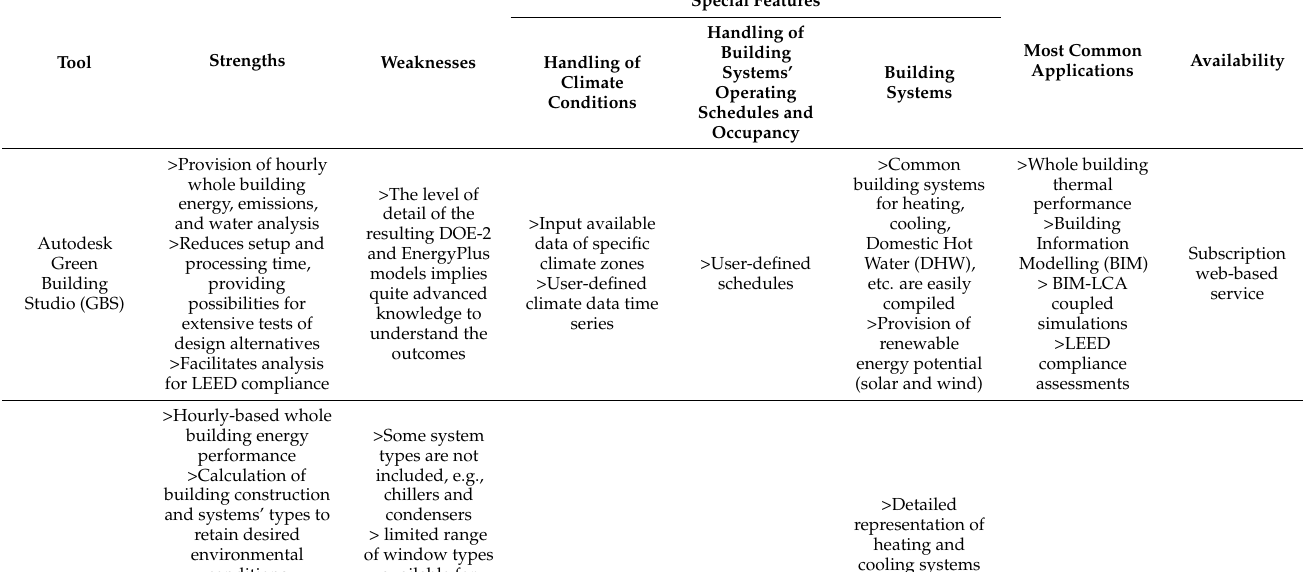
Table 2. Strengths, weaknesses, and special features of computational building energy simulation tools.